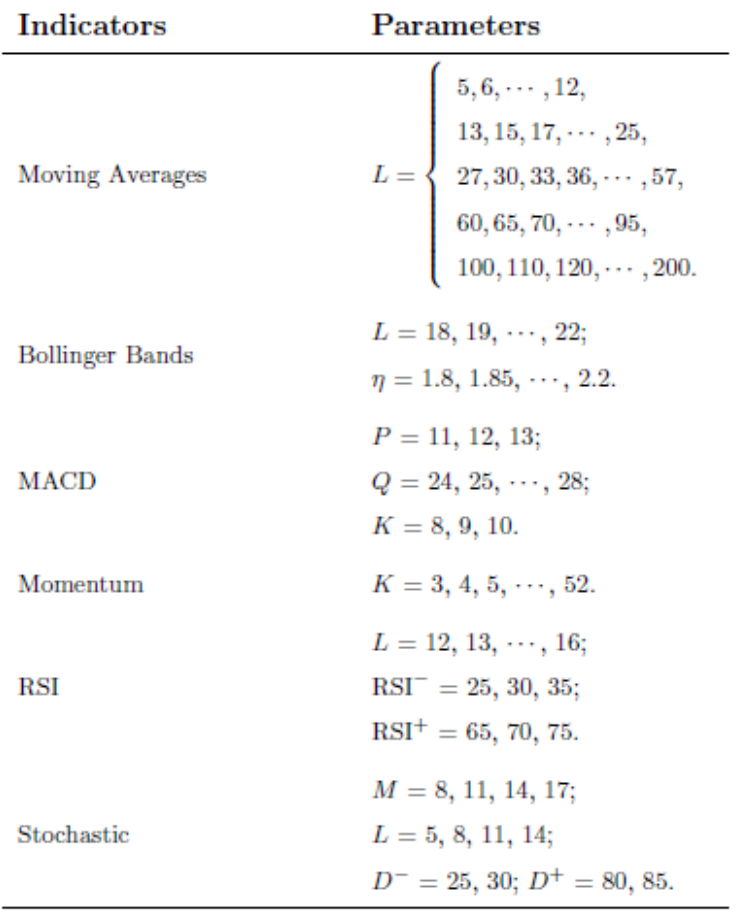
Figure A2. Technical trading rules based on classic indicators, classic-TTR.